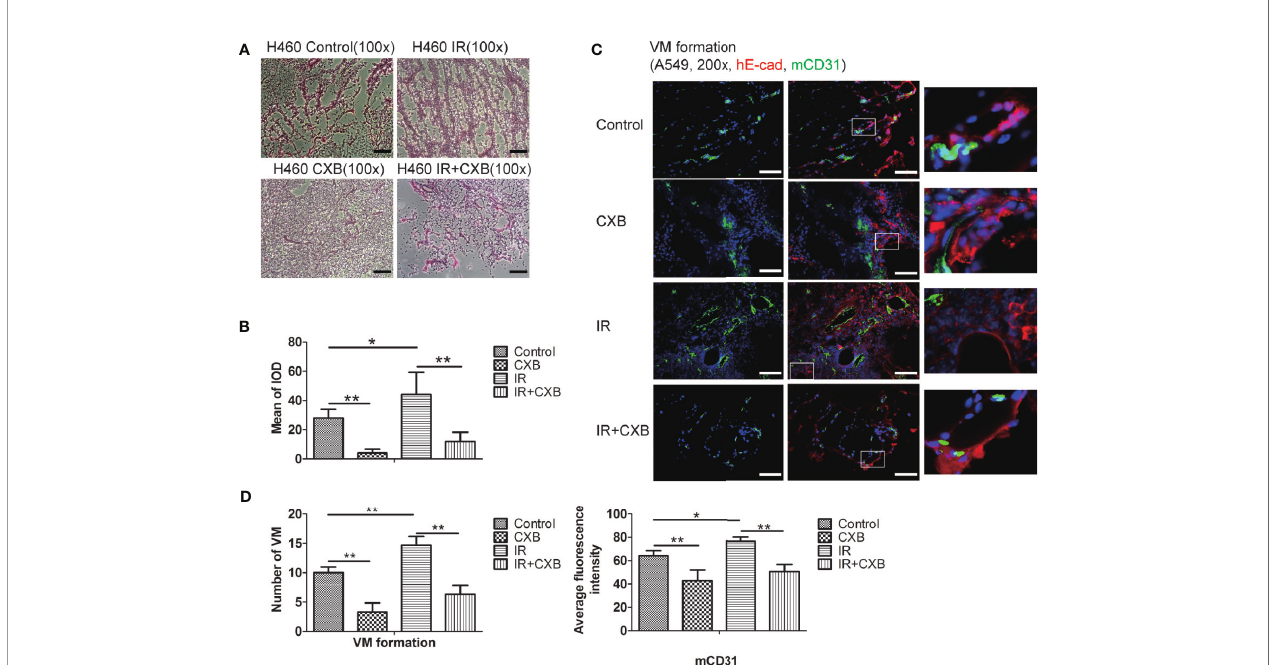
FIGURE 6 | VM change in BALB/c xenografts detected by PAS (H460) and immuno fl uorescence staining (A549). (A) PAS staining (H460): vessel-like structures were composed of tumor cells and basal membrane (VM formation). VM channels were identi fi ed as vessel-like structures composed of tumor cells and were PAS- positive (red). Scale bar, 500 m m. (B) The mean of IOD test by PAS staining in tumor tissues. * p < 0.05, ** p < 0.01. (C) Immuno fl uorescence staining of A549 cells (in A549 xenografts in BALB/c nude mice). mCD31 staining represents mouse-derived endothelial cells (green); hE-cad, a cell – cell adhesion molecule staining represents human tumor-derived basal membrane (red), and DAPI represents the cell nucleus (blue). VM channels were identi fi ed as mCD31-/hE-cad+. Scale bar, 100 m m. (D) The number of VM channels (left) and the expression of mCD31 (right) assessed by immuno fl uorescence staining in tumor tissues. * p < 0.05,